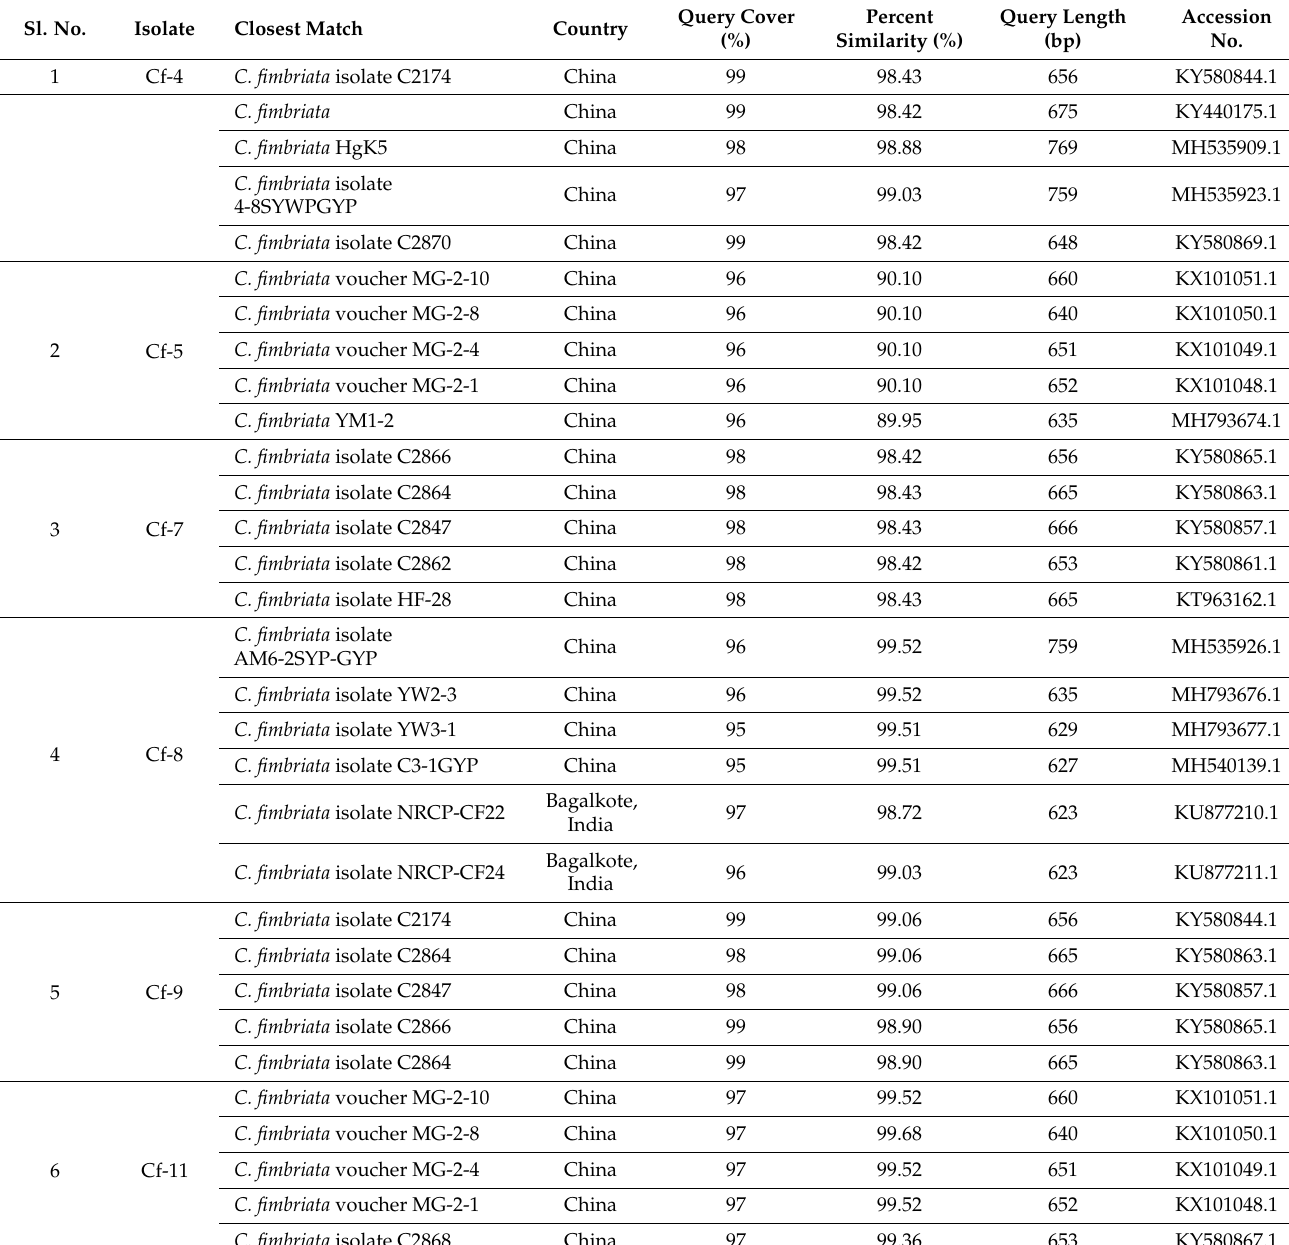
Table 3. Nucleotide sequence similarity of isolates of Ceratocystis fimbriata infecting pomegranate to selected GenBank